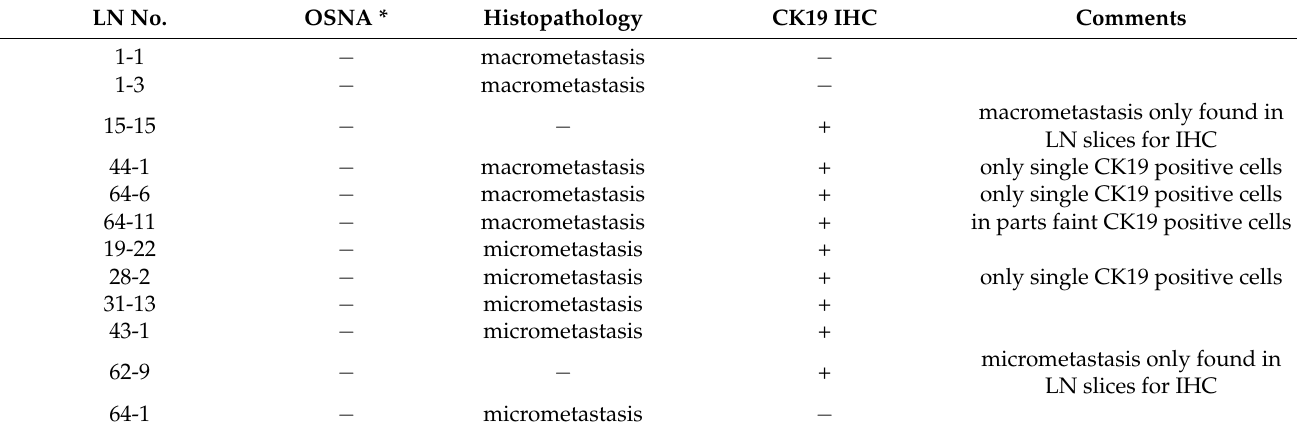
Table 3. Detailed view of OSNA negative/ histopathological positive lymph nodes. LN